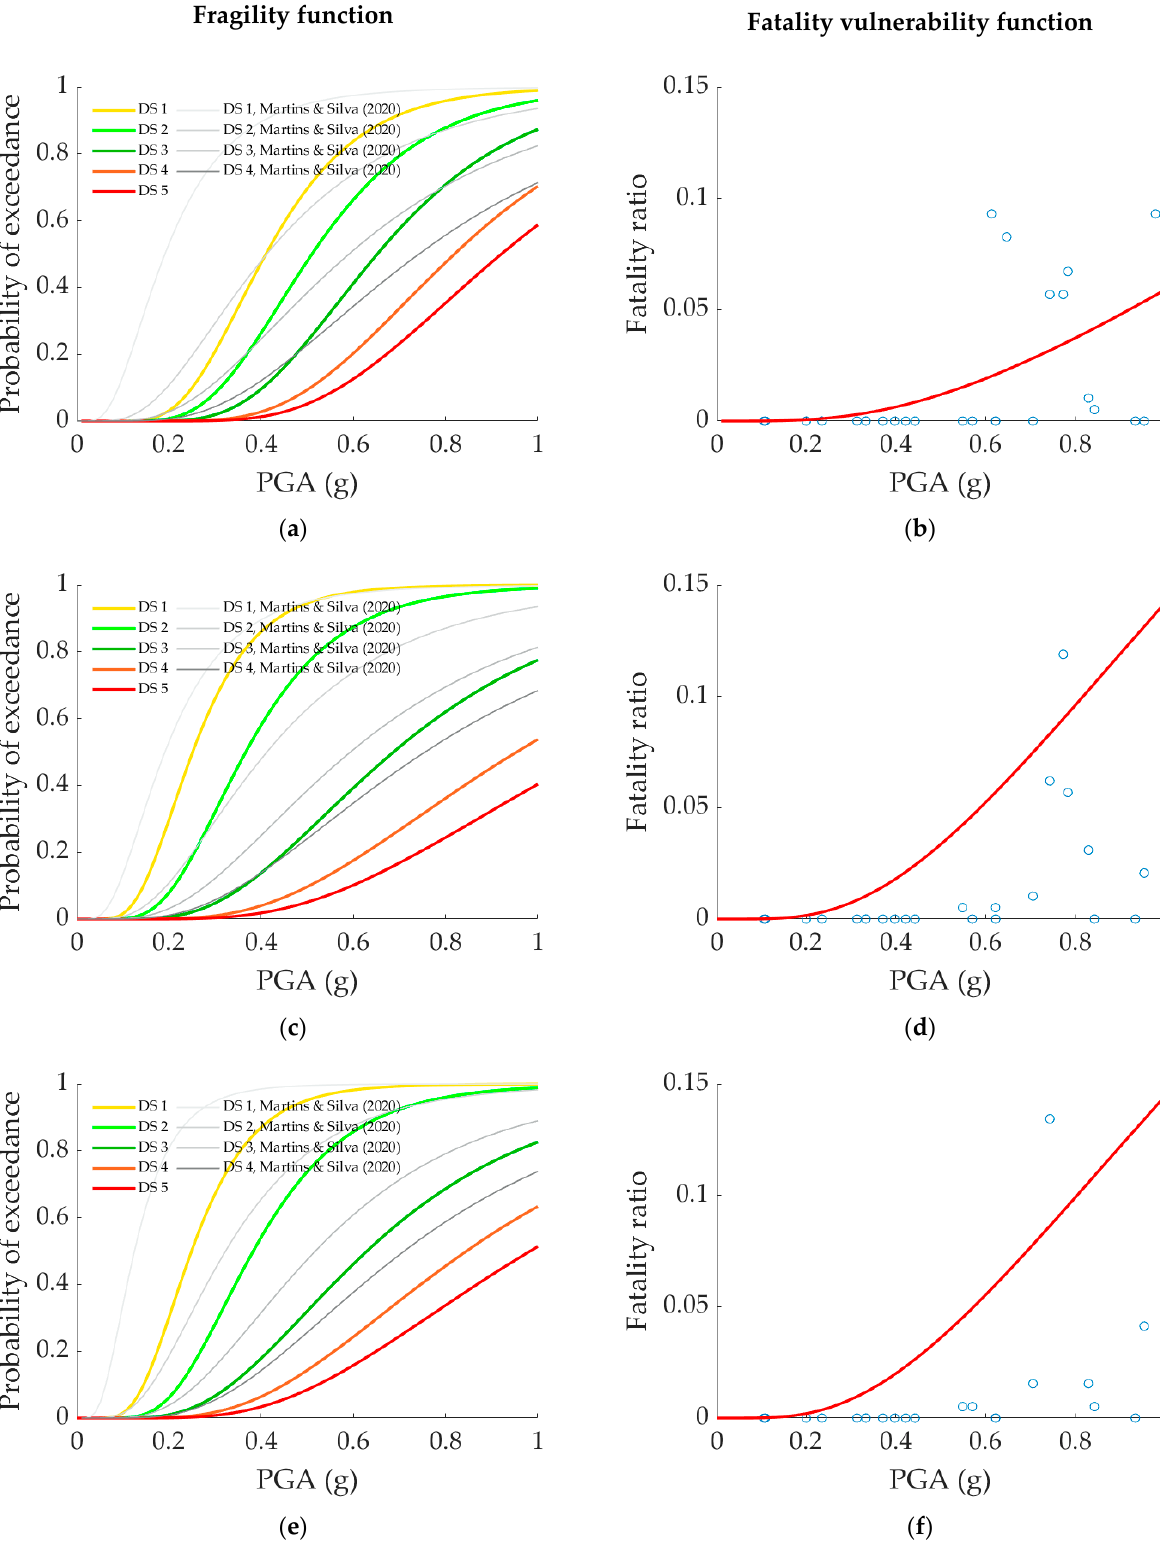
Figure 16. Fragility and fatality vulnerability function for each of the building classes, respectively ( a , b ) 1-story; ( c , d ) 2-story; ( e , f ) 2-story plus an attic.